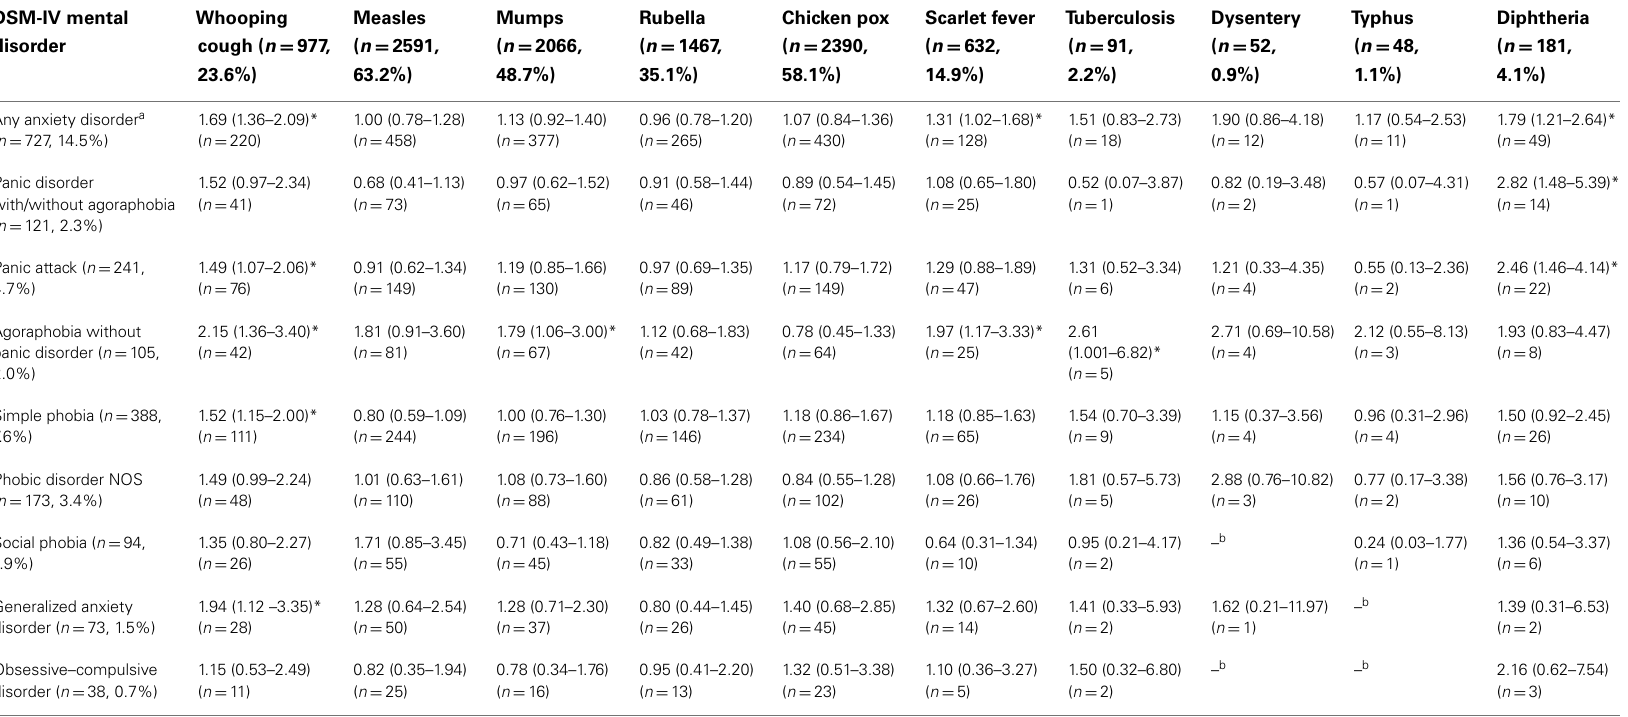
Table 1 | Odds Ratios of infectious diseases (lifetime) for anxiety disorders (12months) compared to the reference group that had no indexed anxiety disorder during the past 12months ( N = 4181)